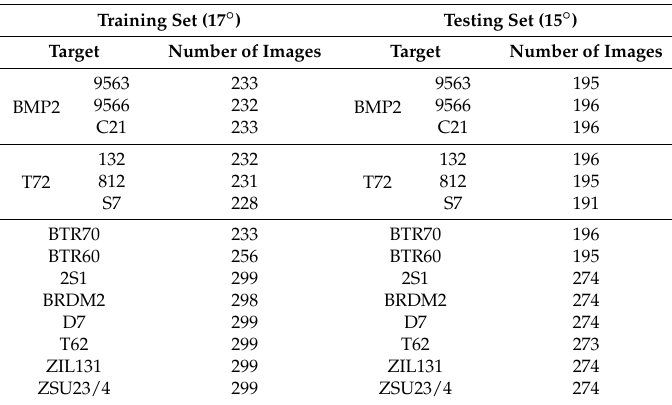
Table 1. The datasets descriptions.